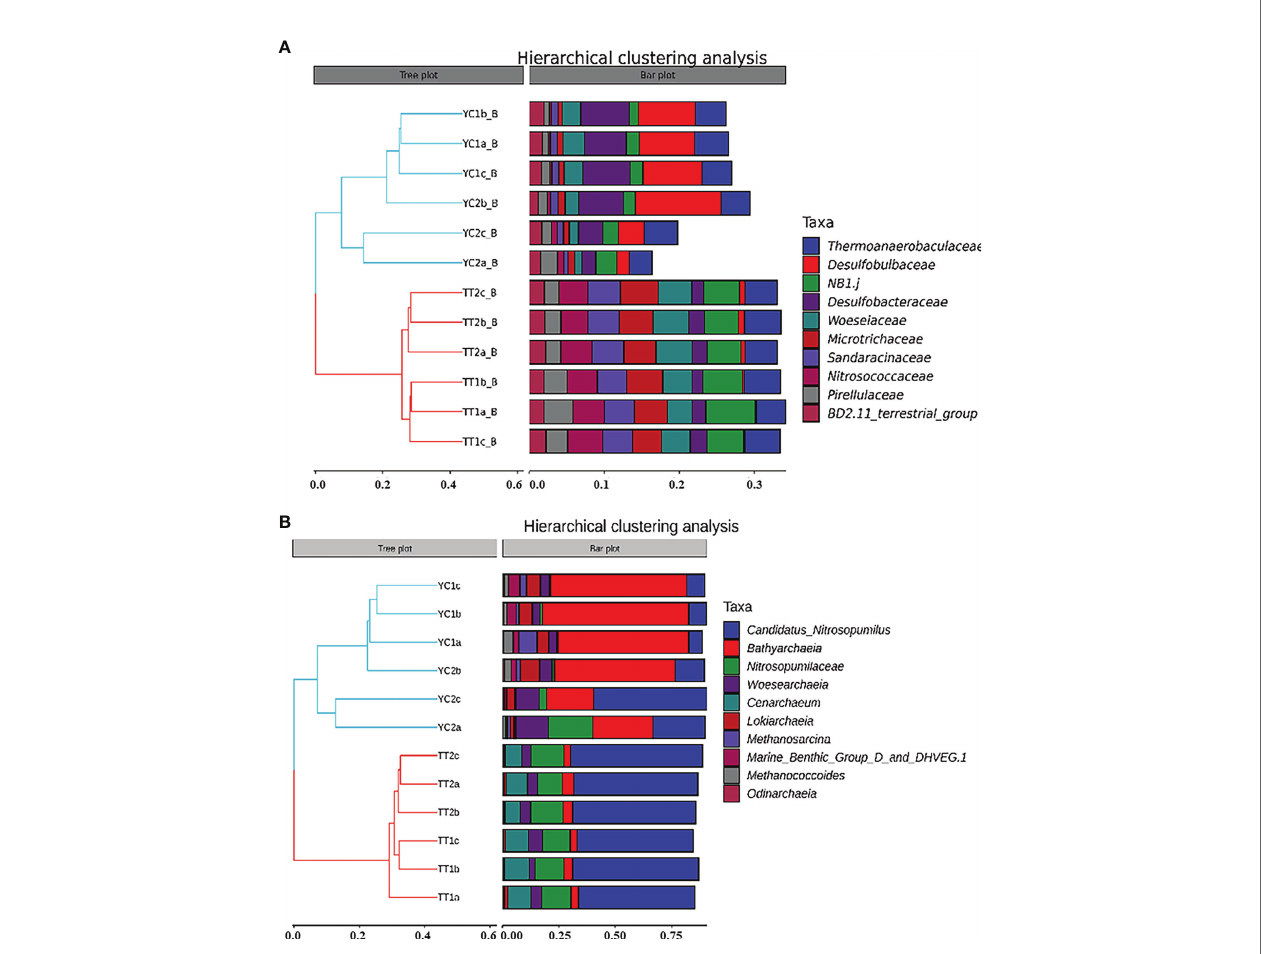
FIGURE 3 | Hierarchical clustering analysis of (A) bacteria and (B) archaea on family level in this study. Photo by Z-Y